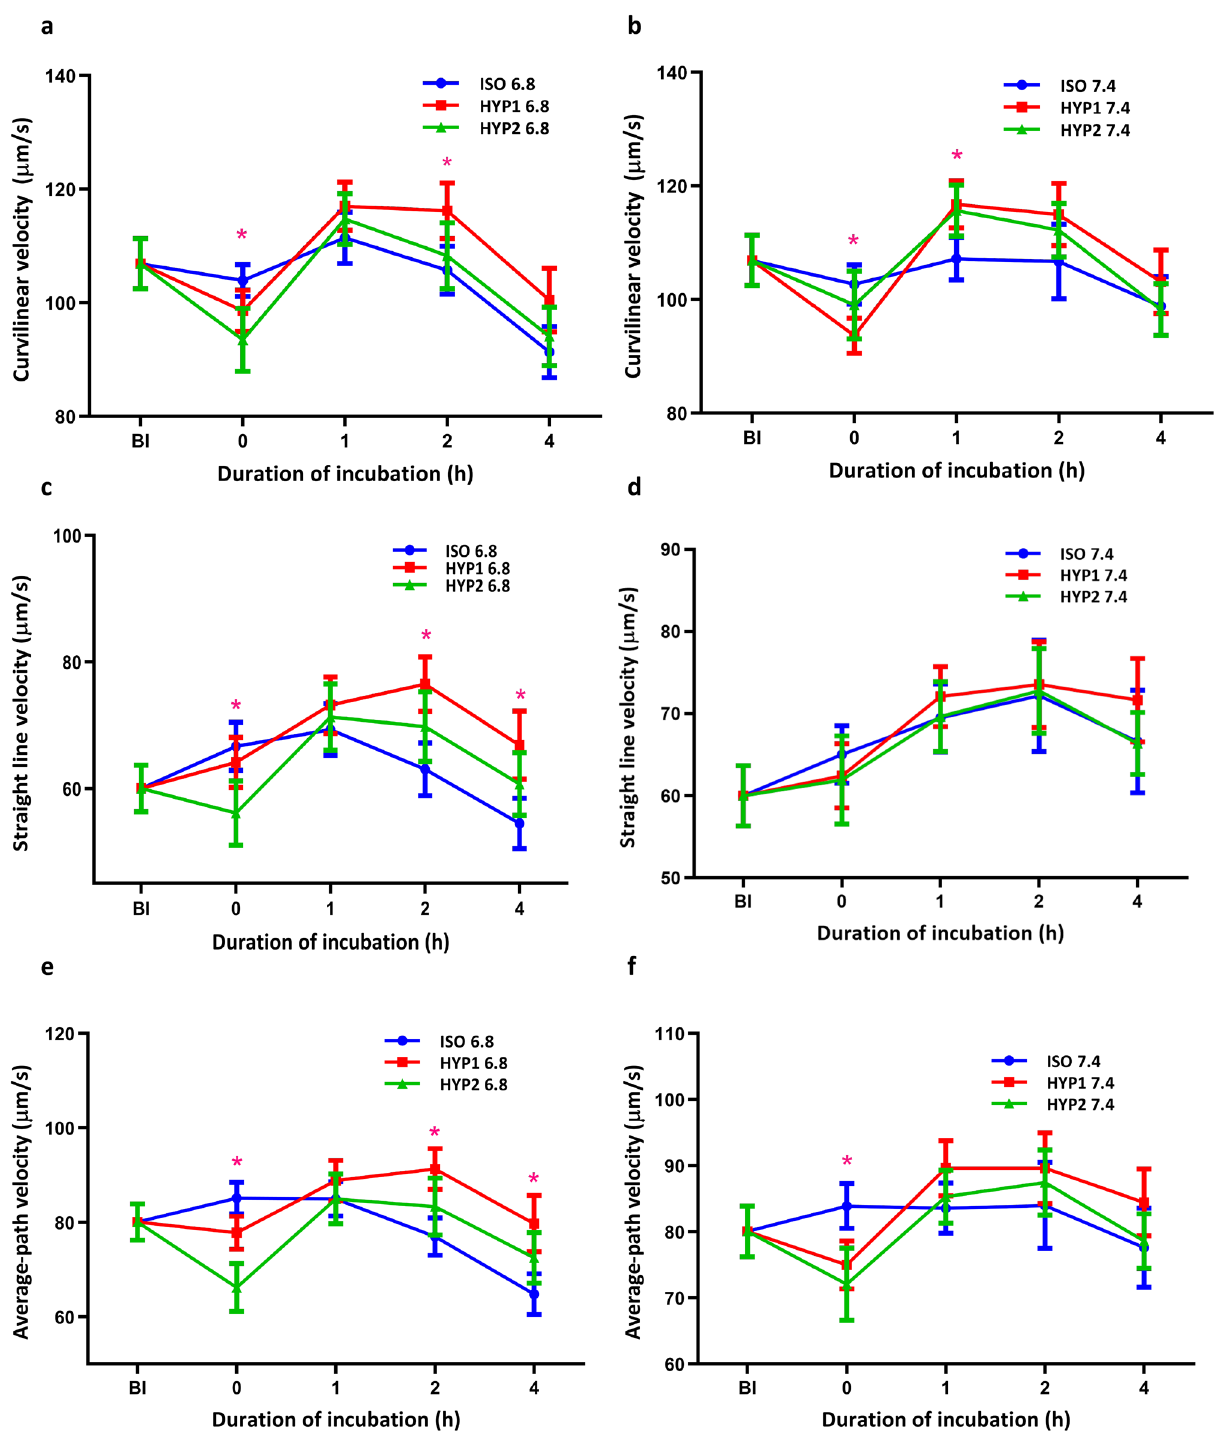
Figure 2. Effect of osmolality and pH on bovine sperm velocities (µm/s) incubated in vitro. The hyperosmotic (HYP1) uterine environment (pH 6.8) significantly ( p < 0.05) increased VCL ( a ), VSL ( c ), VAP ( e ), post osmo- adaptation at 2 h of incubation. However, the hyperosmotic (HYP1) oviduct environment (pH 7.4) did not significantly affect VCL ( b ), VSL ( d ), VAP ( f ) at 2 h of incubation. The interaction of osmolality with incubation time was significant ( p < 0.05) for VCL, VSL and VAP. The interaction between pH and incubation time was significant ( p < 0.05) for VSL and VAP. *represent the effects of osmolality, differ significantly ( p < 0.05) at a particular time point. (ISO: 290 mOsm/kg; HYP1: 355 mOsm/kg; HYP2: 420 mOsm/kg; BI:Before incubation; VCL: Curvilinear velocity; VSL: Straight line velocity; VAP: Average path